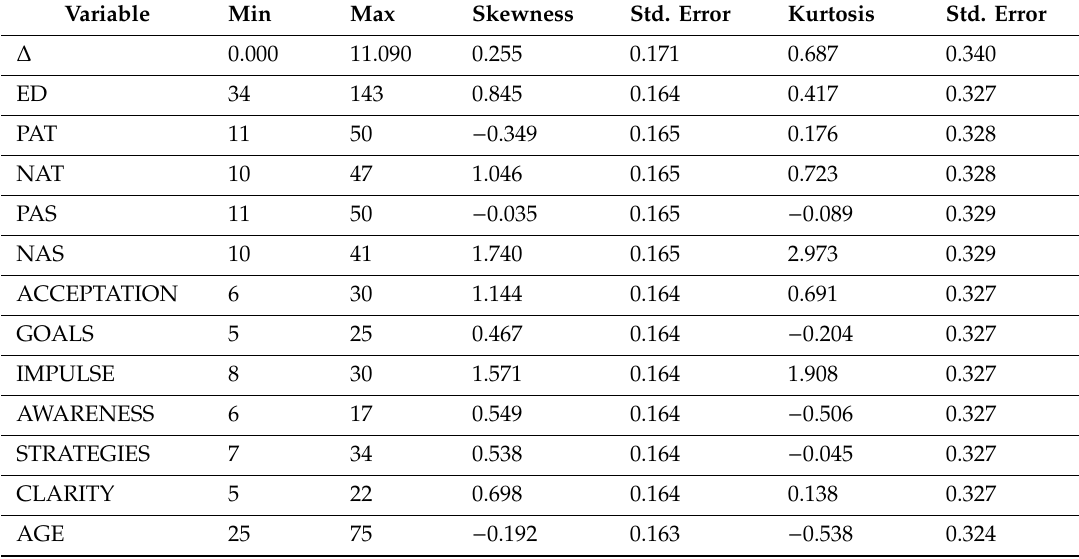
Table 3. Minimum values, maximum values, and the skewness and kurtosis of normality coe ffi cients.